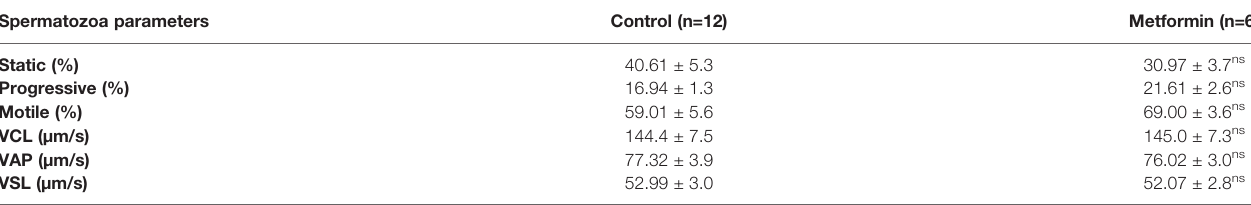
TABLE 2 | Consequences of in utero metformin exposure on spermatozoa